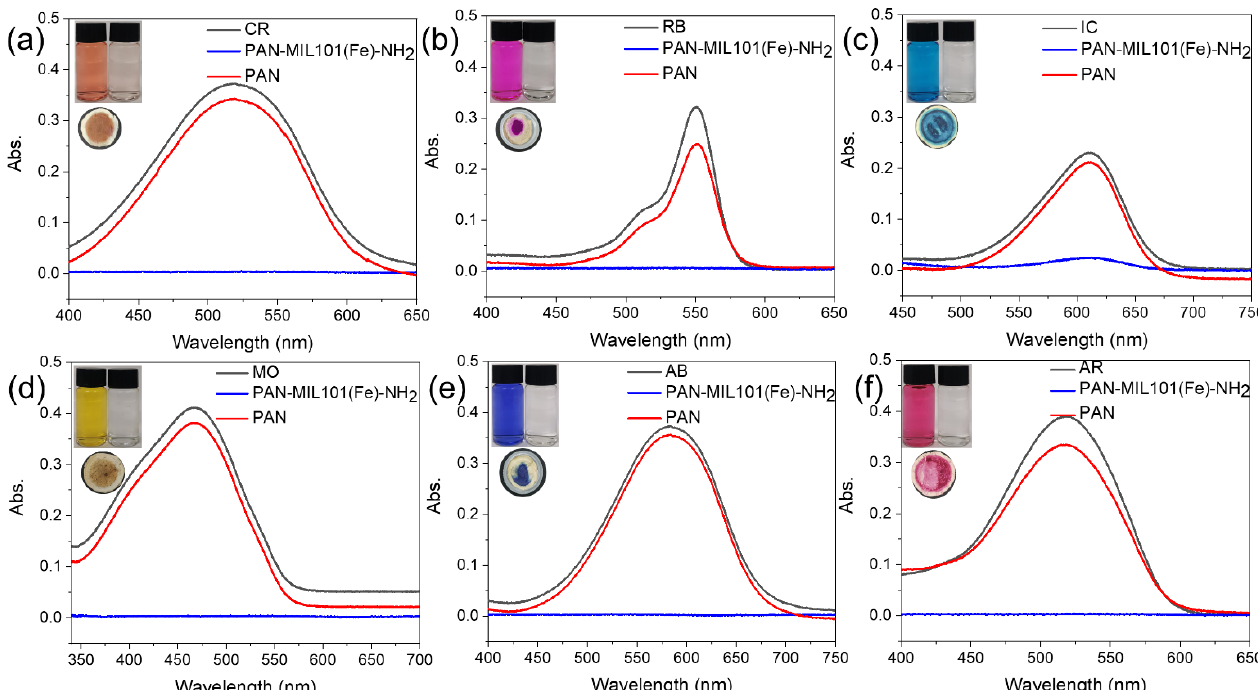
Figure 5. Absorption spectra of the six dyes by the PAN and PAN-MIL101(Fe)-NH 2 NFM ( a – f ). Insets are the color contrast of the solution before and after the adsorption and the optical image of the PAN-MIL101(Fe)-NH 2 NFM after adsorption.